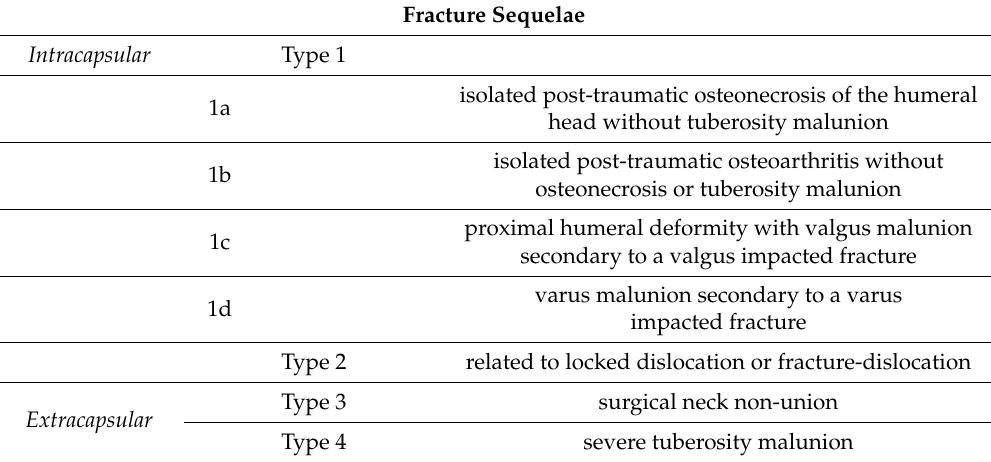
Table 1. Boileau and Moineau classification of humerus proximal part fracture